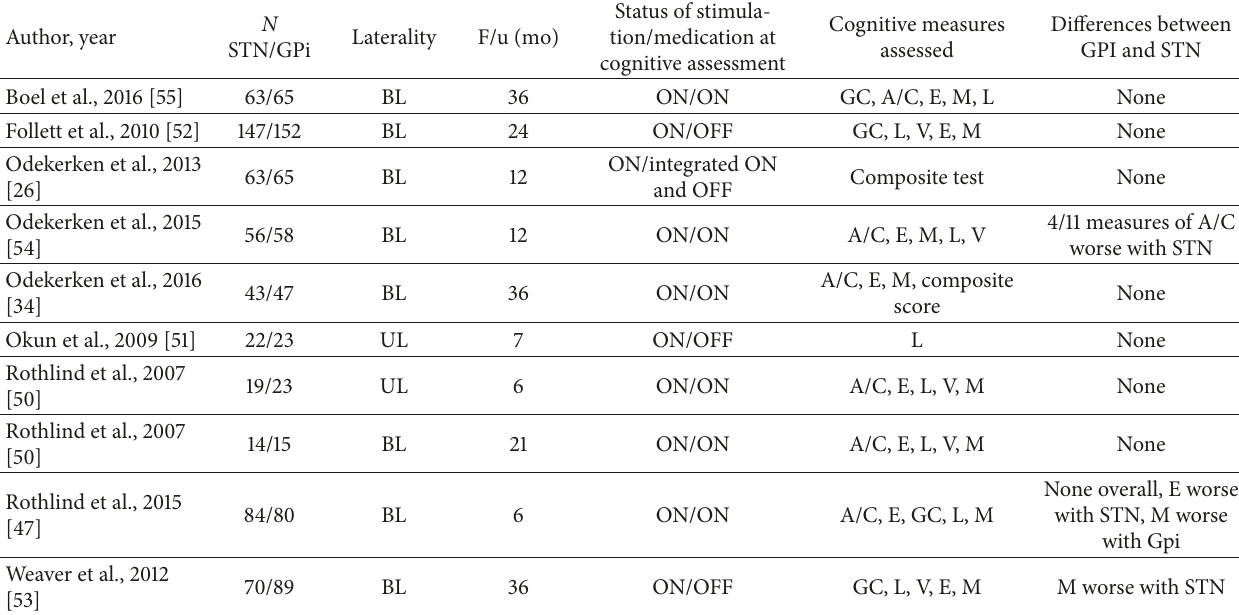
Table 4: Studies comparing cognitive outcomes between GPi and STN DBS in PD